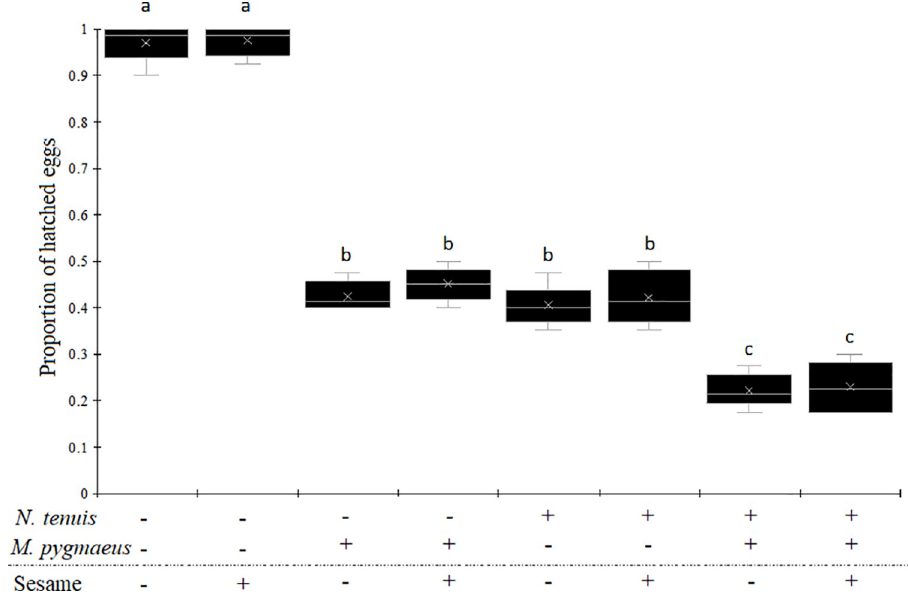
Fig 1. Proportion of hatched eggs of Tuta absoluta according to the presence or absence of Nesidiocoris tenuis and/or Macrolophus pygmaeus and the presence or absence of sesame plant. The ‘+’ indicates the presence and the ‘-’ indicates the absence. Boxplot followed by the same lower case letter did not differ